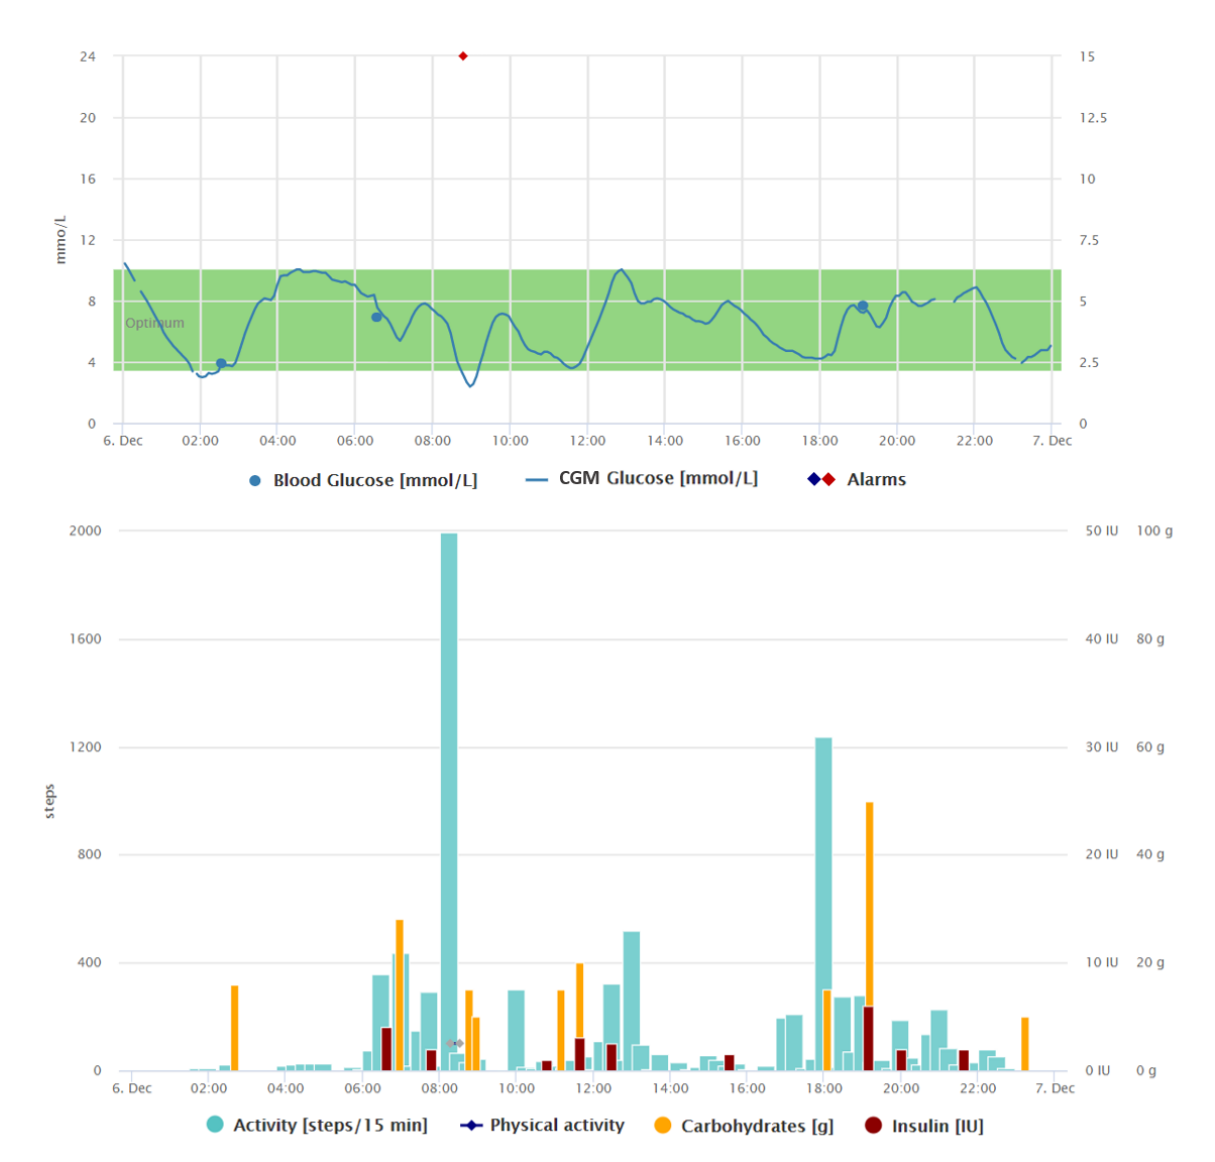
Figure 4. Graphical interpretation of 1-day data registrations of the patient from case study 3, visualized by the Diani Web app. In the picture, we can notice variable activities during the day composed of 1 high-intensity physical activity at around 8 am and then frequent changes between sitting and walking patterns. Regarding food intake, there are very different amounts of carbohydrates throughout the day. Patient´s reaction on blood glucose level made by correction boluses is another typical pattern. CGM: continuous glucose